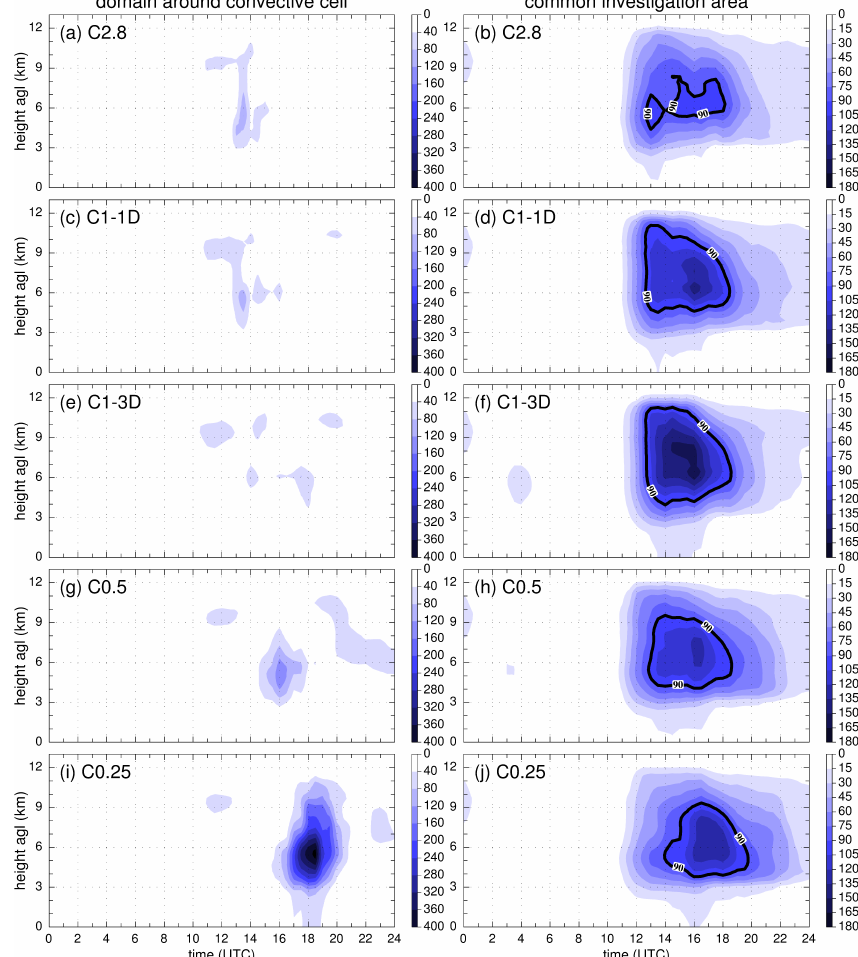
Figure 17. Domain-averaged vertical profiles of cloud condensate (liquid water, ice, snow, graupel, and rain) in mgkg − 1 on 23 July 2013 for an area around the convective cell (left column) and the common investigation area (right